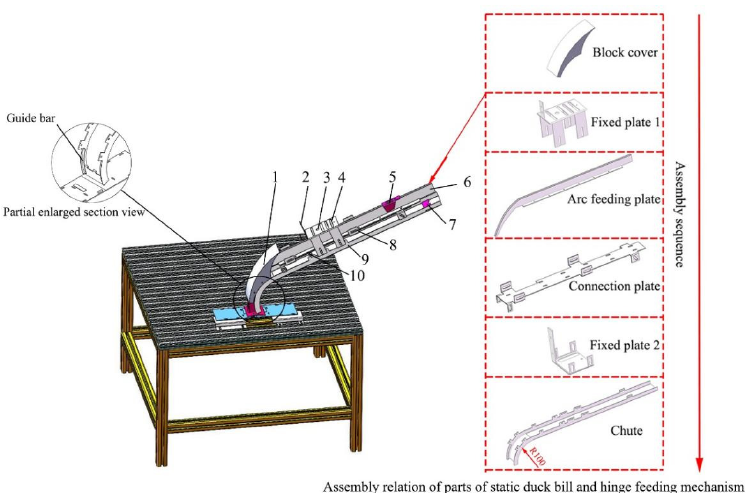
Figure 13. Structure diagram of static duckbill and hinge feeding mechanism. 1. Block cover; 2. cylinder; 3. inductive proximity switch; 4. electromagnet; 5. static duckbill; 6. arc feeding plate; 7. girdle; 8. connecting plate; 9. storage chute; 10. fixed plate